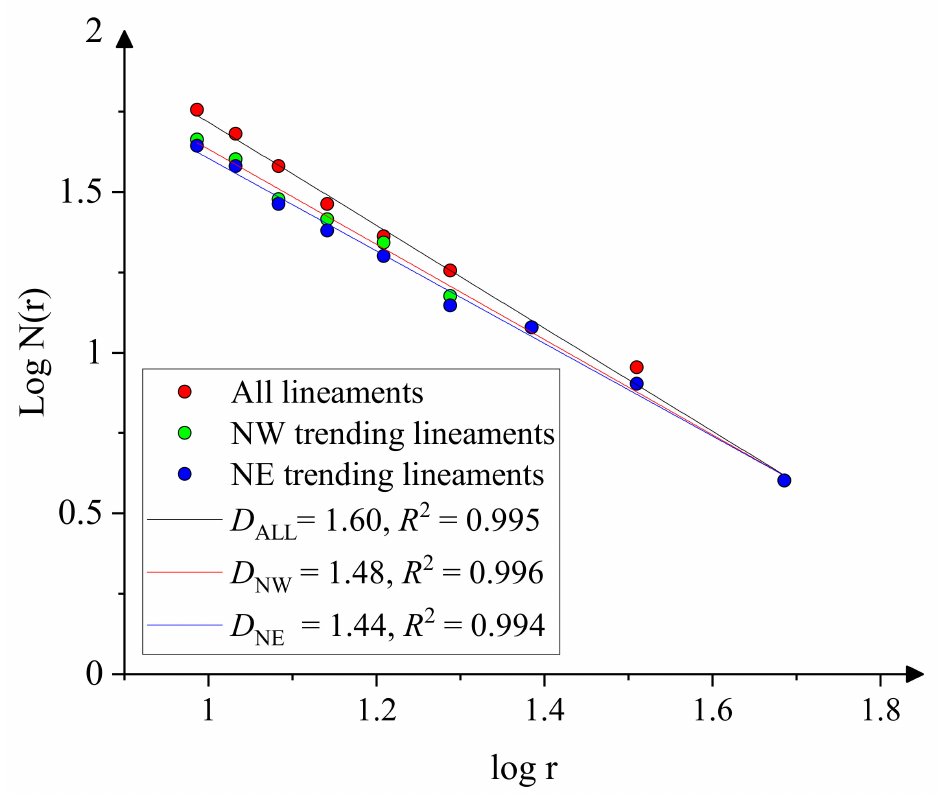
Figure 5. The fractal dimension of lineaments in the Qianhe Graben.